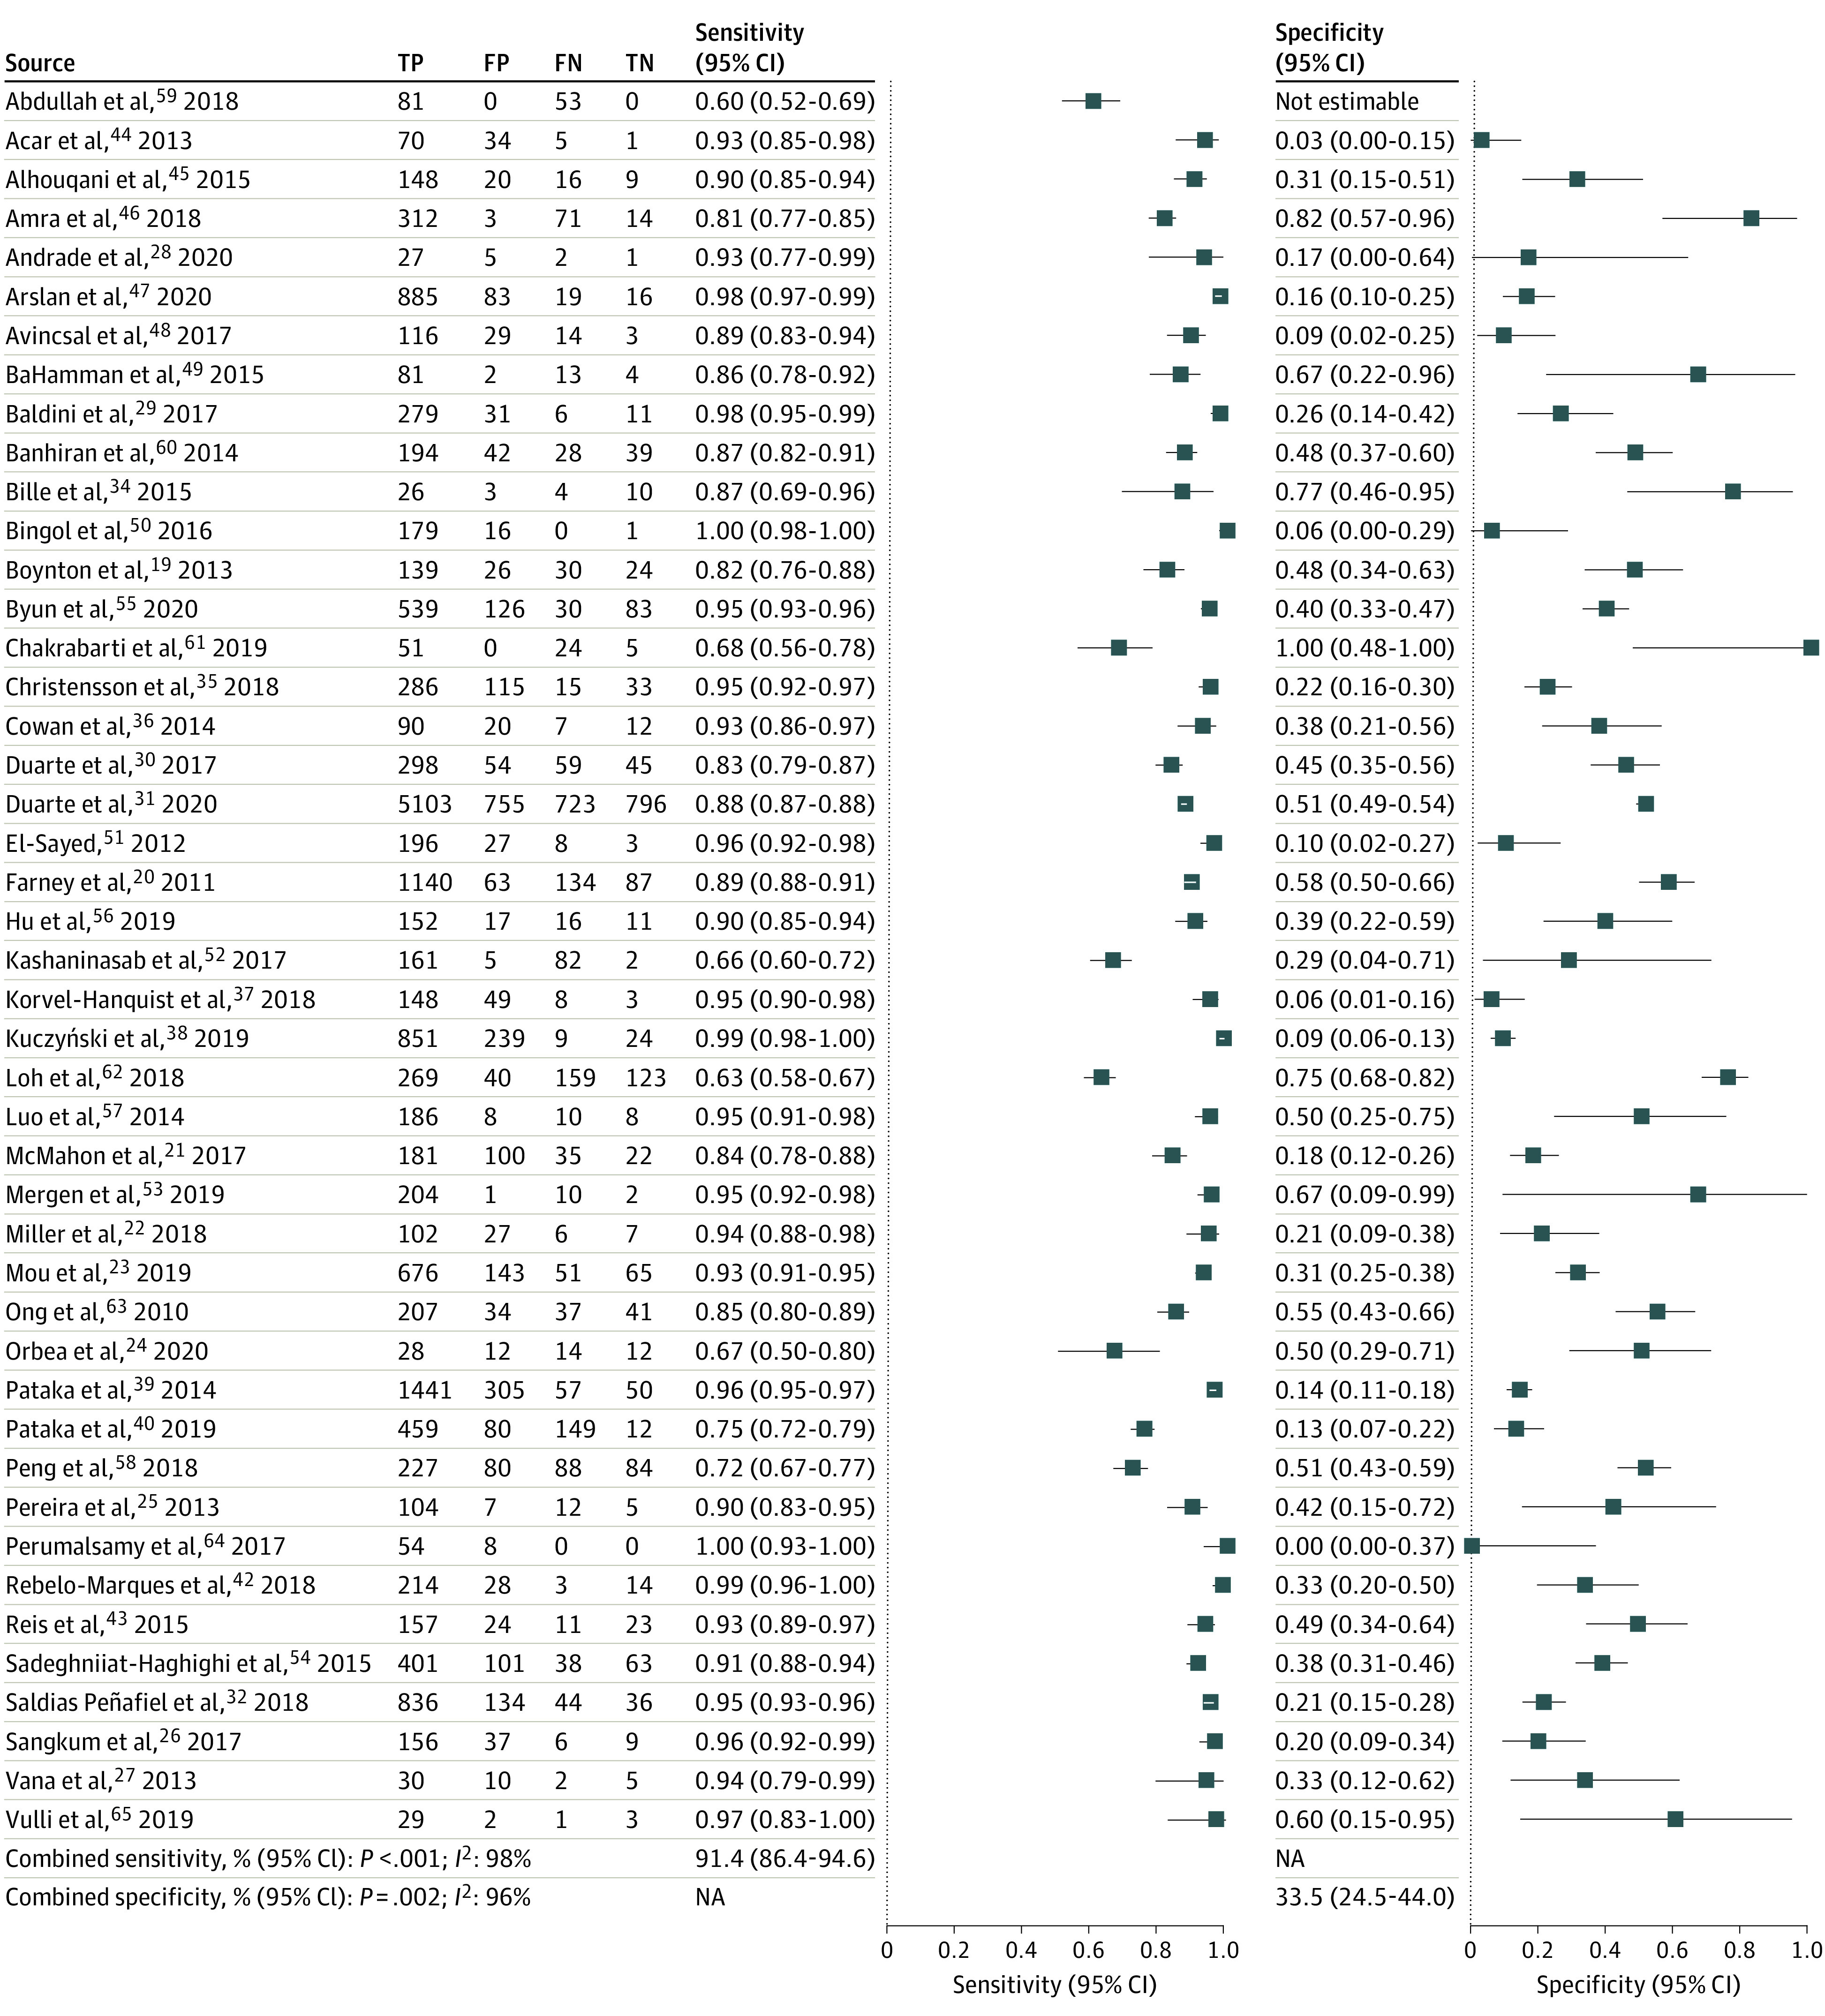
Forest Plot for Combined Sensitivity and Specificity for All Obstructive Sleep Apnea for All Included Studies in the Sleep ClinicFN indicates false-negative; FP, false-positive; NA, not applicable; TN, true-negative; TP, true-positive.